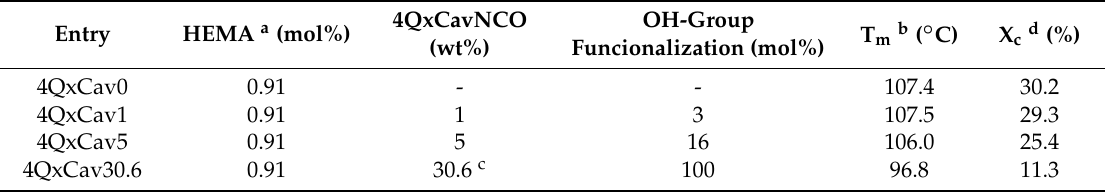
Table 1. Overview of the prepared velcrand functionalized PE, theoretical amount of velcrand introduced in wt%, and thermal data.